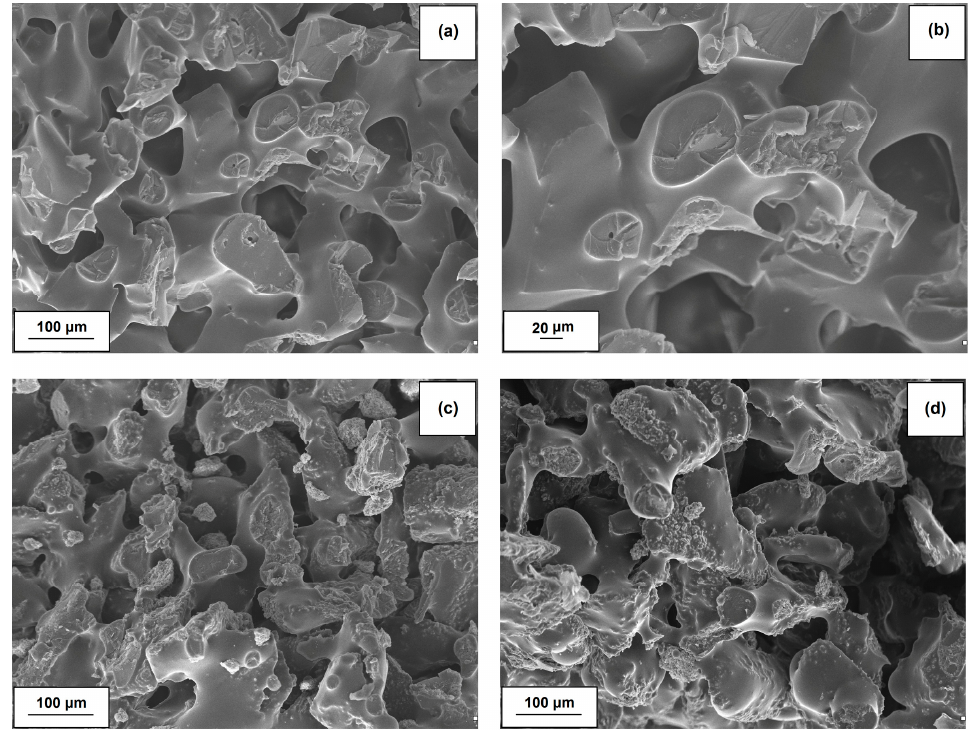
Figure 11. SEM images of novolac + corundum + resole composite ( a , b ) and novolac + corundum + resole + lignin-Al 2 O 3 systems with ratios of organic-inorganic filler equal to 8:1 wt / wt ( c ) and 8:6 wt / wt ( d ).